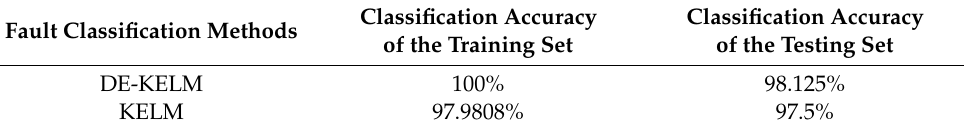
Figure 23. Fault classification results by KELM on the feature matrix calculated through GWO-VMD- based decomposition method. Table 14. Fault classification accuracy of training and testing sets by